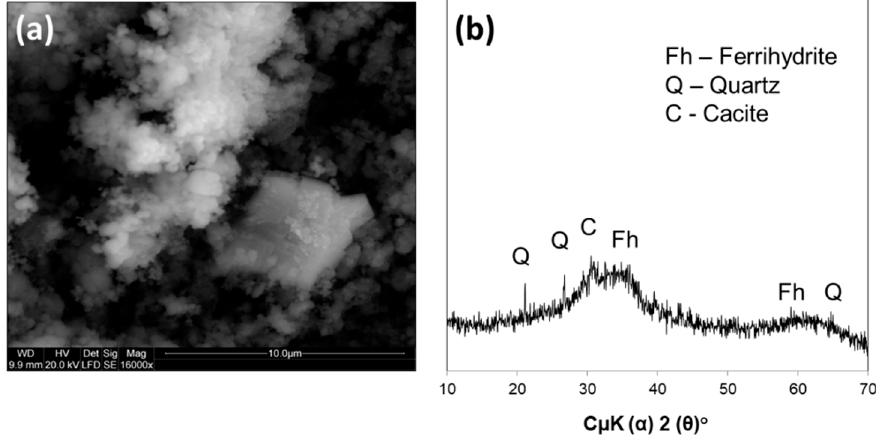
Figure 1. Water treatment residuals ( a ) SEM image; ( b ) X-ray diffraction pattern (author’s